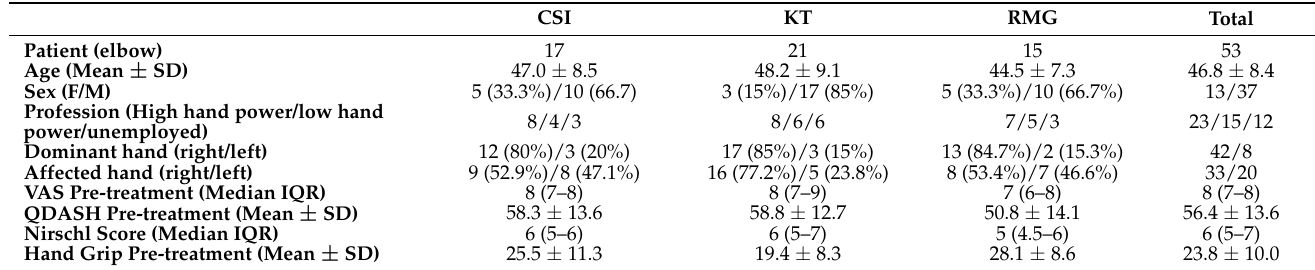
Table 2. Demographic characteristics of patients.